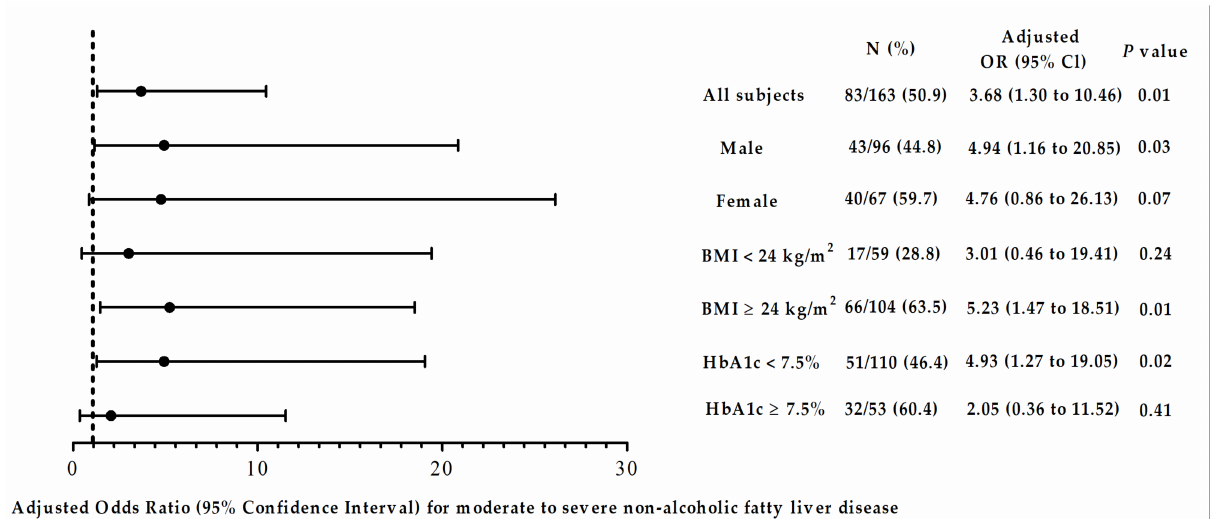
Figure 2. Adjusted odds ratios (ORs) of the severity of non-alcoholic fatty liver disease in patients with T2D stratified by sex, body mass index cut at 24 kg/m 2 , and glycated hemoglobin (HbA1c) cut at 7.5%. Ratios were adjusted for age, sex, body mass index, glutamate pyruvate transaminase (GPT), log-formed triglyceride, and high-density